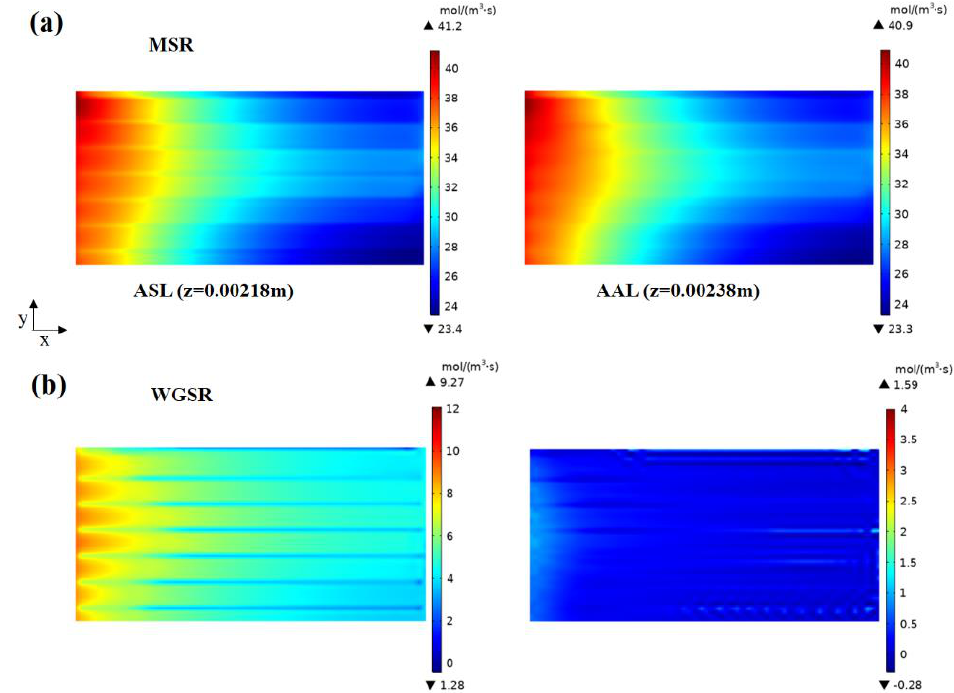
Figure 7. Reaction rate(mol·m −3 ·s −1 ) distributions in anode layer for methane syngas fuel for: ( a ) MSR, ( b ) WGSR.